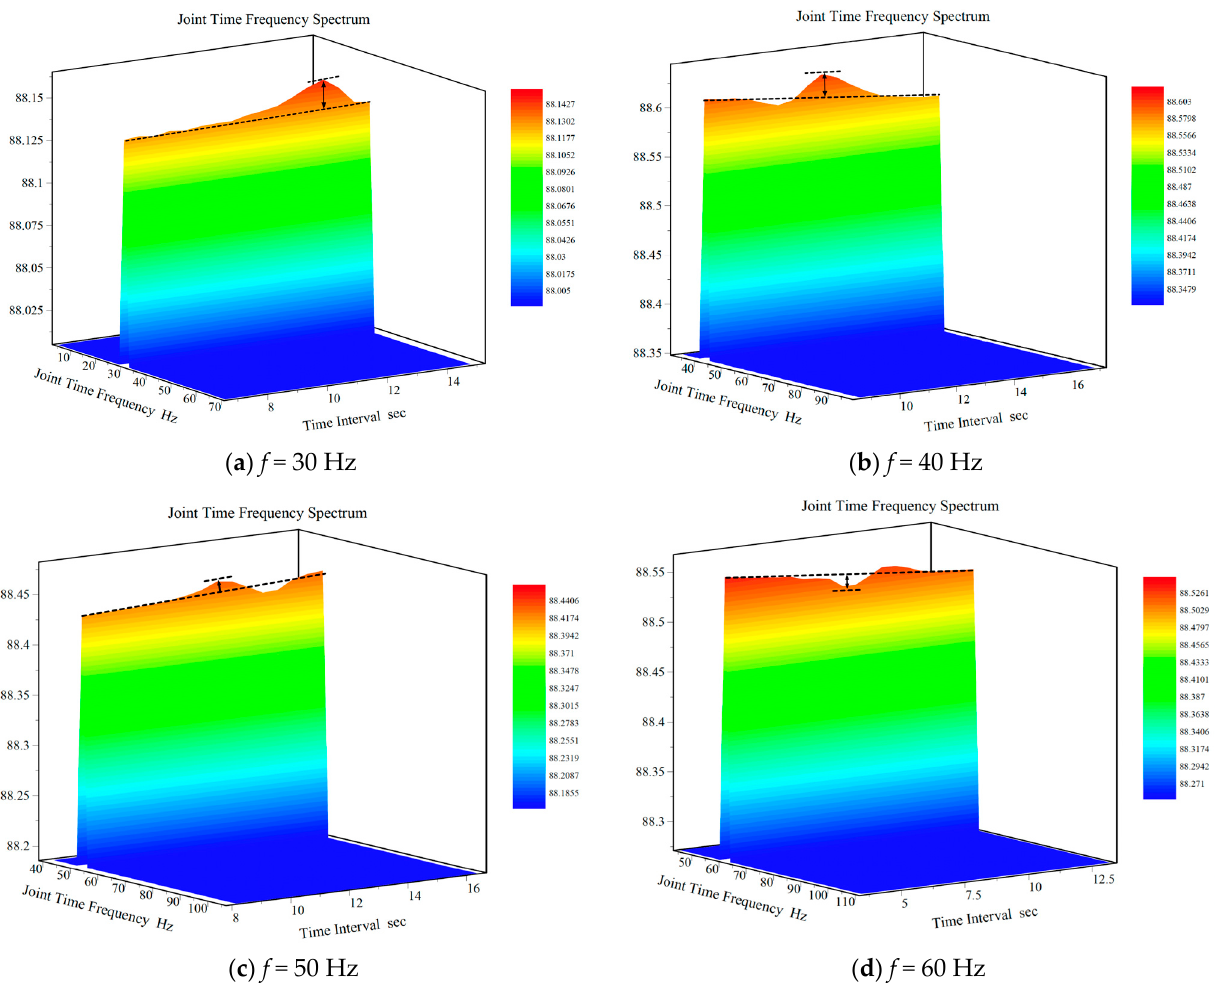
Figure 6. The JTFS of the first orientation of the copper triangular pyramid detected by sinusoidal excitation signals of different frequencies.